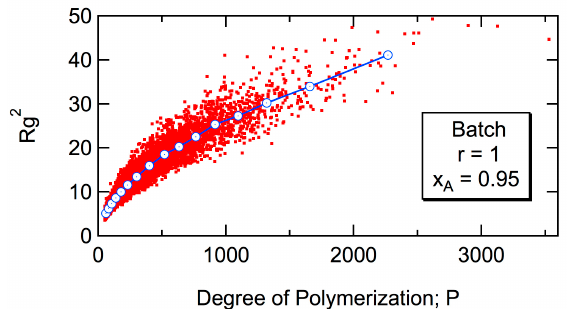
Figure 11. Relationship between Rg 2 and P with r = 1 and x A = 0.95 for batch polymerization.